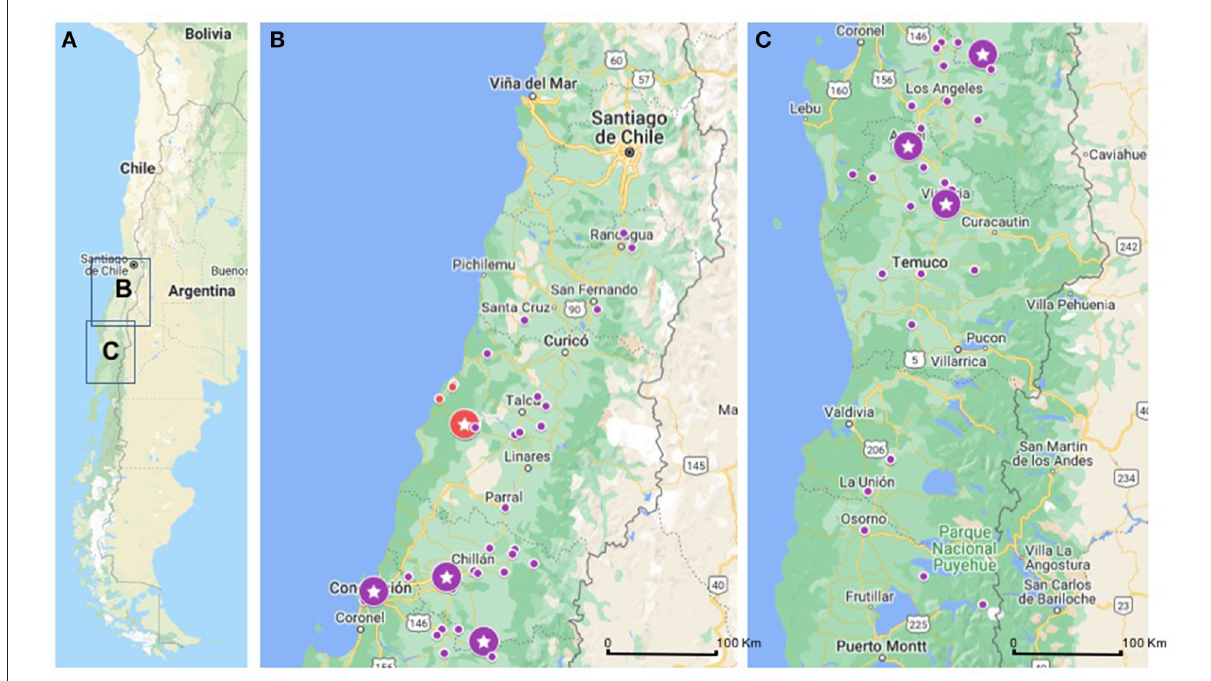
FIGURE1 Chilean distribution of blood-flesh peach. (A) Chilean map, southern part of America continent. The squares indicate two selections areas. (B) O’Higgins, Maule and Ñuble regions, (C) Bio-Bio, Araucanía, Los Rios and Los Lagos regions. The purple dots represent the presence of at least one blood-flesh peach 20 years-old or older. The purple stars represent the presence of a population of at least 10 trees more than 20 years old. The red dots and start represent the population and territory under study.